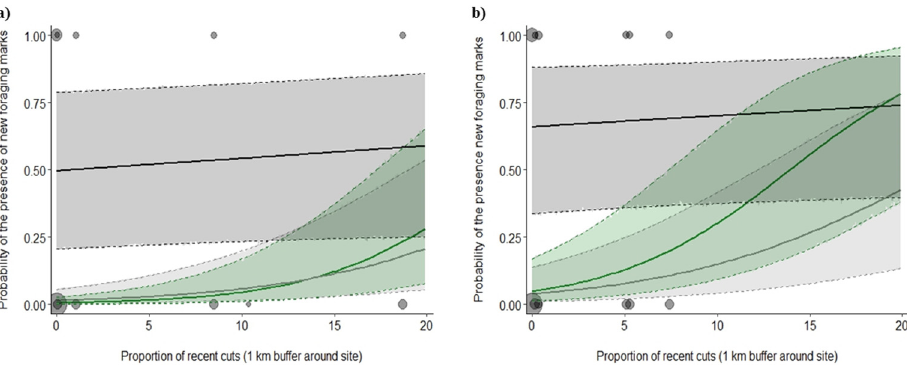
Figure 4. Predicted probability (±SE; back-transformed from the logit scale) of the presence of new woodpecker foraging marks on girdled trees during the three sampling seasons. Different letters within a sampling season indicate significantly different least-squares means among treatments. Lines with an associated p -value represent different least-squares means between sampling seasons, regardless of treatment.